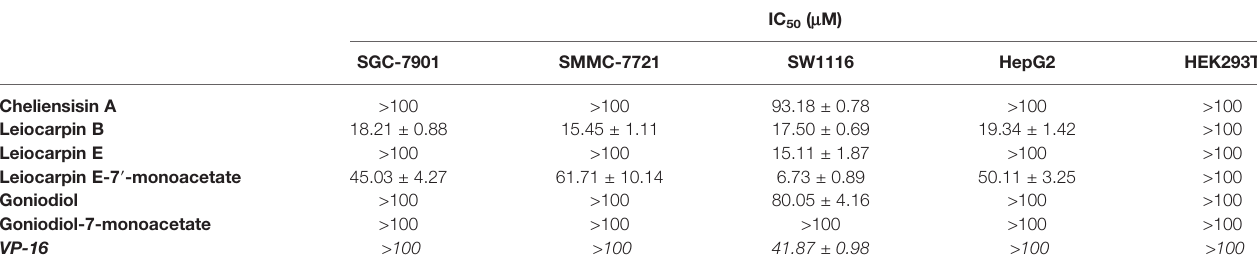
Data are means ± SEM (n=3). Results are representative of three separate experiments.